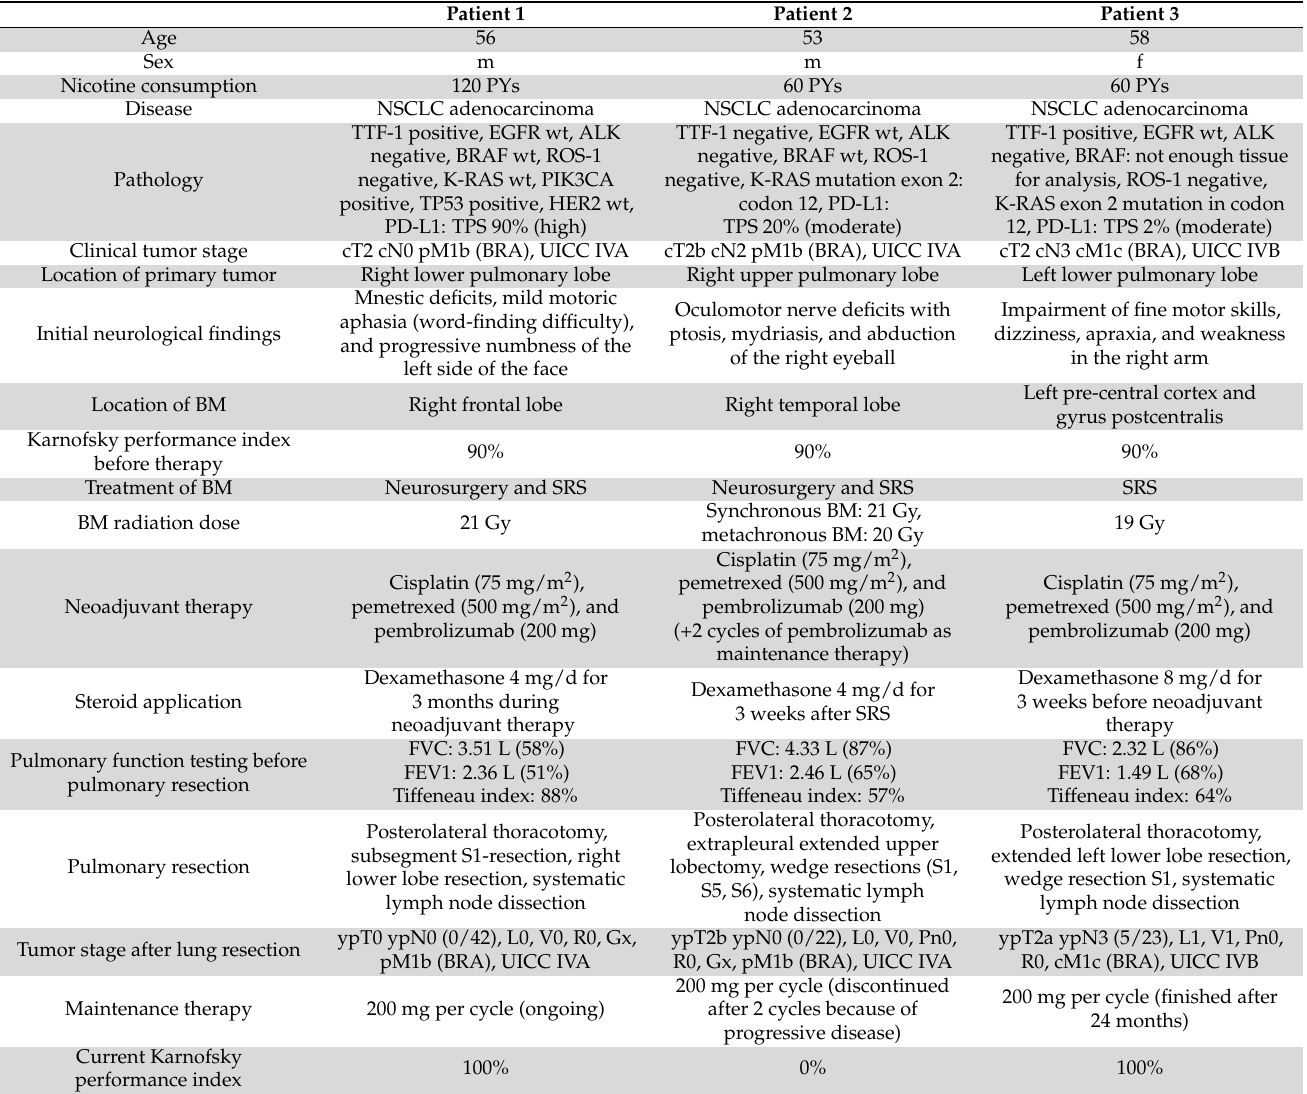
Table 1. Overview of the three